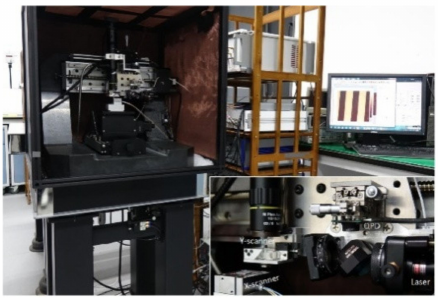
Figure 9. Photo of the novel HS-AFM. Inset: photo of the AFM head.